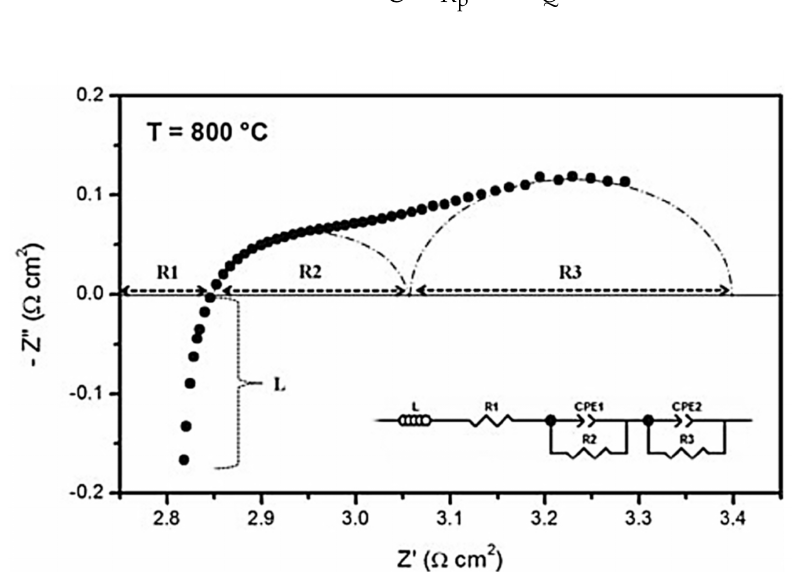
Figure 9. Impedance spectra of an LSCF symmetrical cell measured at 800 ◦ C and equivalent circuit used to fit the impedance circuit (inset). (Reprinted with permission from Reference [48], copyright John Wiley and Sons,